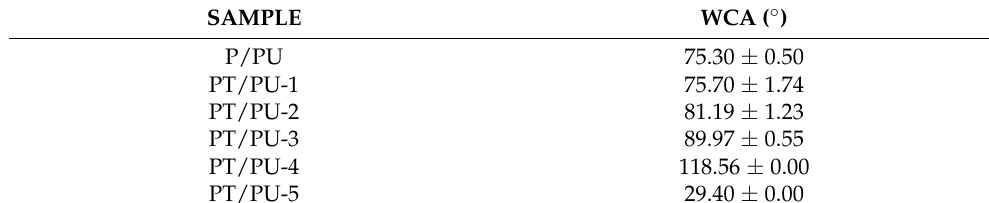
Table 1. Equilibrium values of contact angle for the synthesized P/PU and PT/PUs.